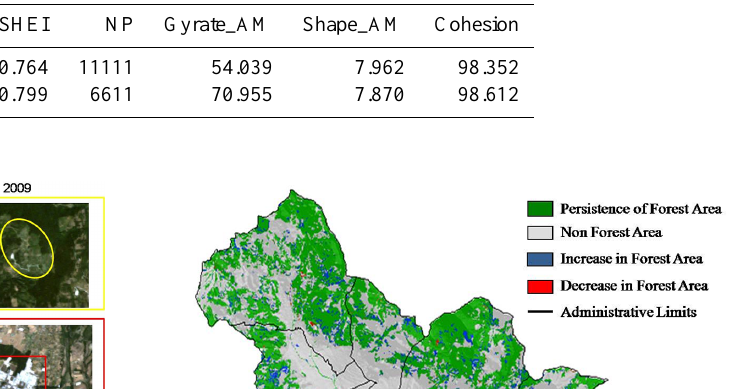
Table 4. Results of metrics applied at landscape level for the 14 classes of ecomosaics for the years 1985–2009. The suffix AM means “area-weighted mean”.